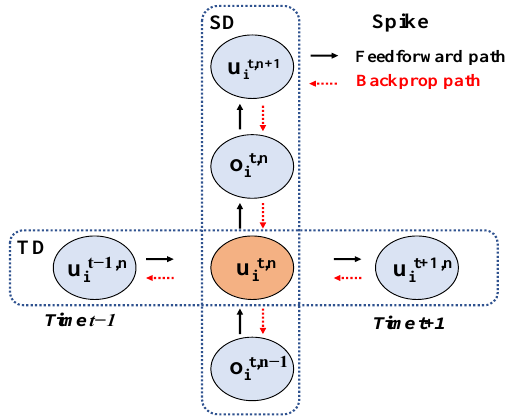
Figure 5. At the single-neuron level, the vertical path and horizontal path represent the error propagation in the SD and TD,